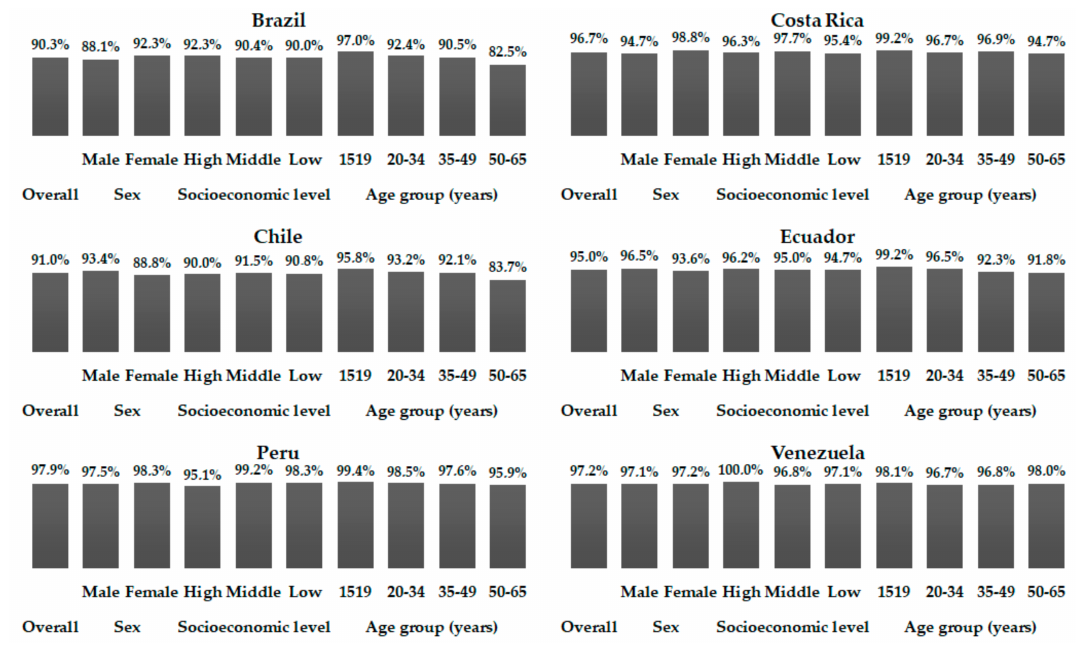
Figure 2. Percentages of individuals with added sugar intake up to 5% of the total energy intake among Latin American countries, according to gender, socioeconomic level, and age ranges; Latin American Health and Nutrition Study (ELANS),